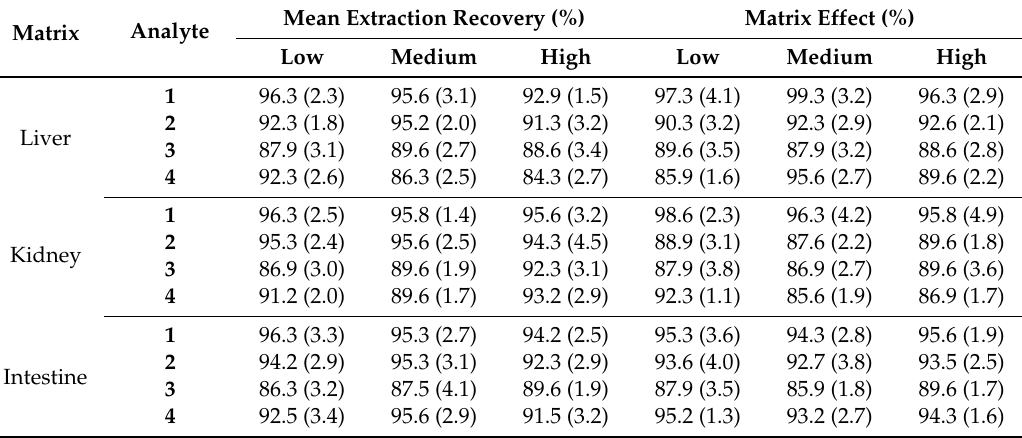
Table 3. Mean extraction recoveries and matrix effect of the analytes in liver, kidney, and intestine extract ( n = 5). Percentage SDs are in parentheses.